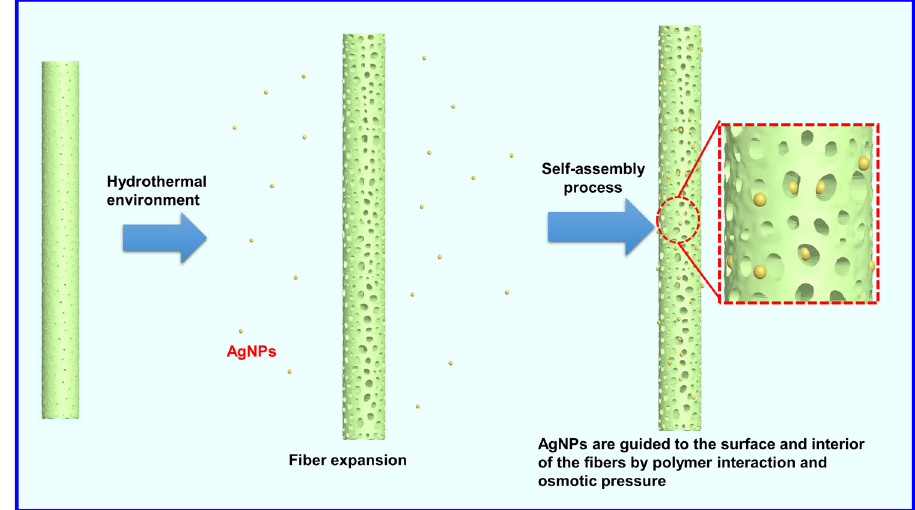
Figure 2: Schematic representation of the self - assembly of HBPAA - capped AgNPs on polyester fi ber surfaces in a high - temperature and high - pressure hydrothermal